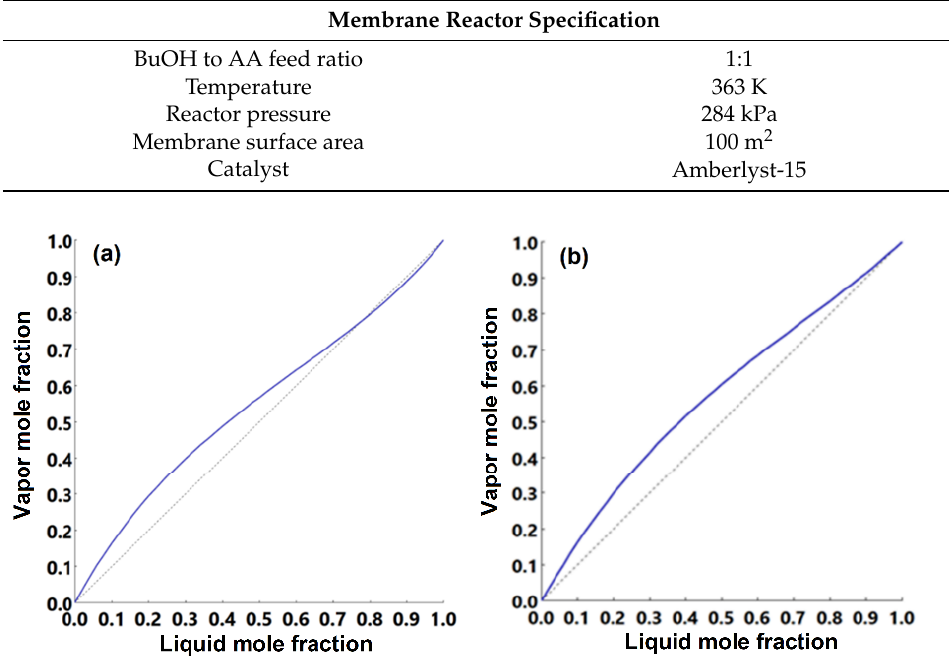
Figure 9. Equilibrium x - y diagram of n -butanol/butyl acetate mixture at: ( a ) 101 kPa and ( b ) 304 kPa.